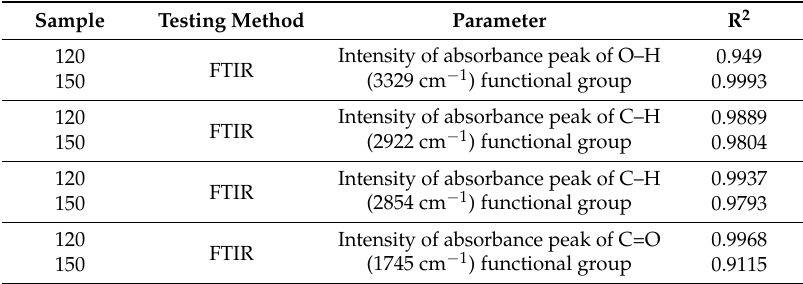
Table 6. The value of R 2 from the correlation between the average number of chain scissions and the functional groups of the transformer